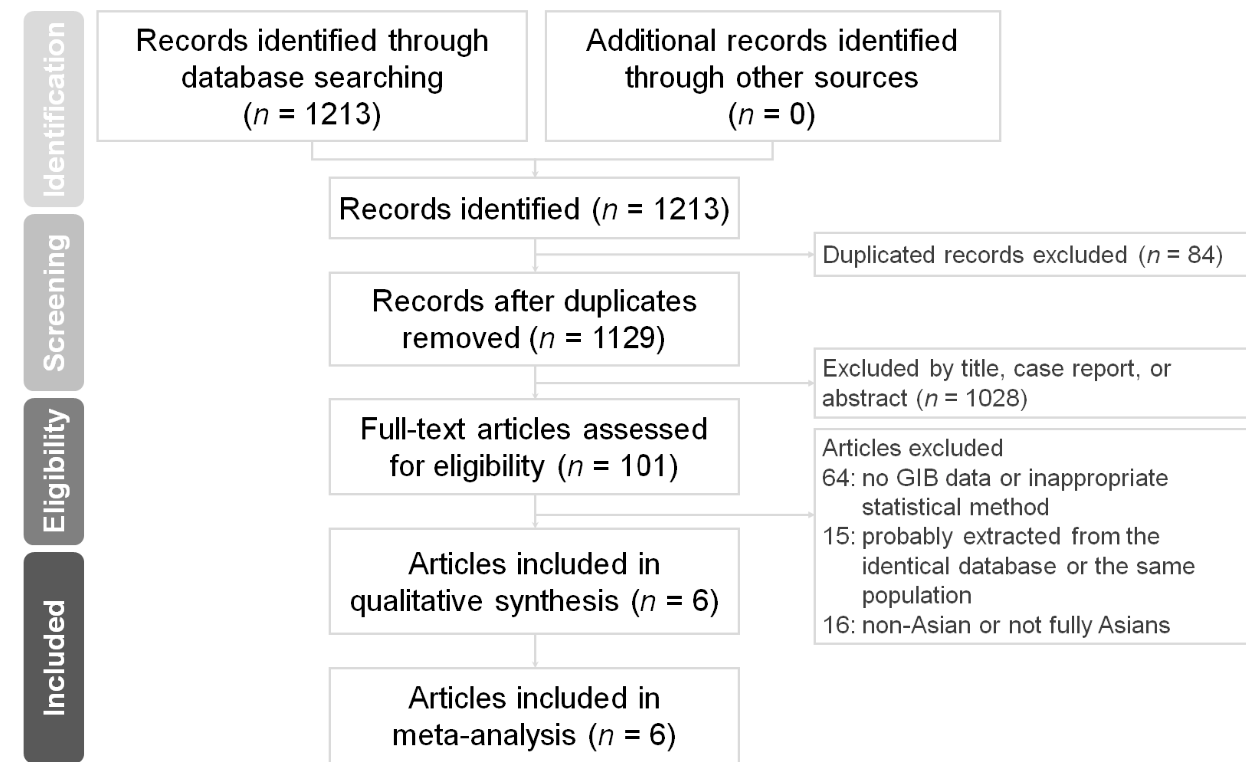
Figure 1. Preferred Reporting Items for Systematic Reviews and Meta-Analyses (PRISMA) flow chart. Preferred reporting items for systematic reviews and meta-analyses flow diagram for the searching and identification of included studies.